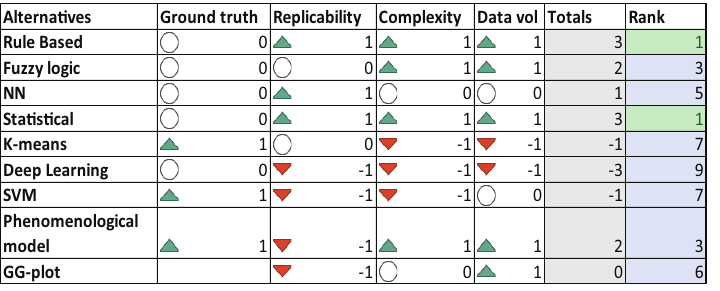
Figure 7. Decision matrix—Driving Style.